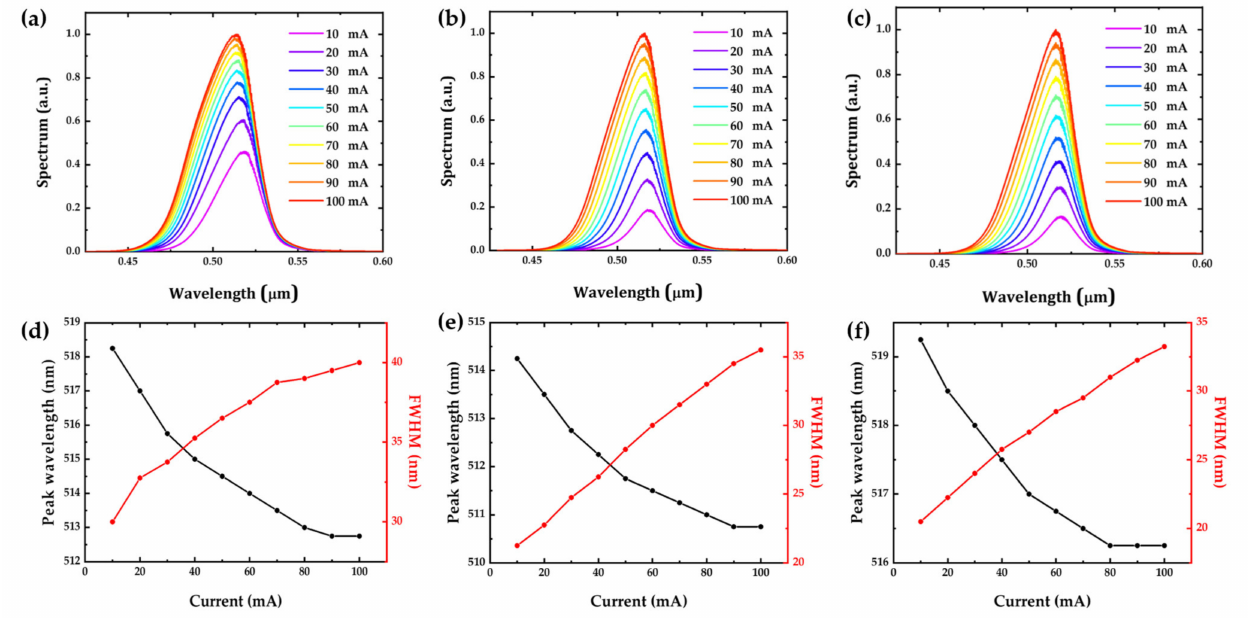
Figure 2. The emission spectrum of the ( a ) c-plane (0001), ( b ) semipolar (2021), and ( c ) m-plane (1010) micro-LED, and the wavelength shift and FWHM as a function of current of the ( d ) c-plane (0001),